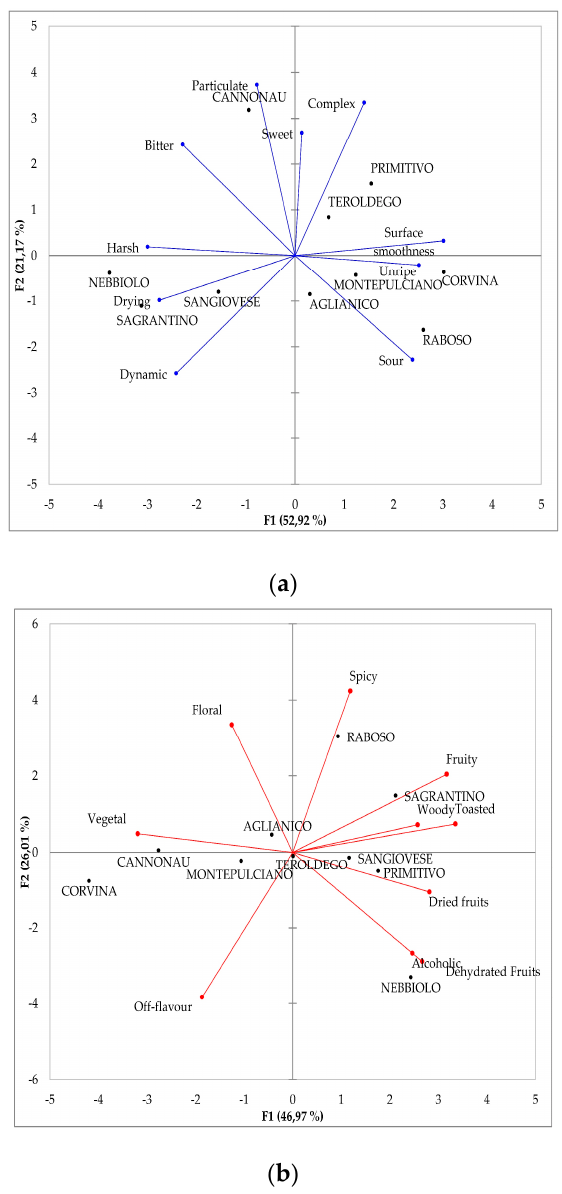
Figure 1. Principal component analysis (PCA) plots carried out on the correlation matrices (Pearson, p < 0.05) of the mean intensities over the 10 single-varietal wines rated by the 14 judges for significant: ( a ) oral (astringency and tastes) characteristics and ( b ) olfactory attributes.